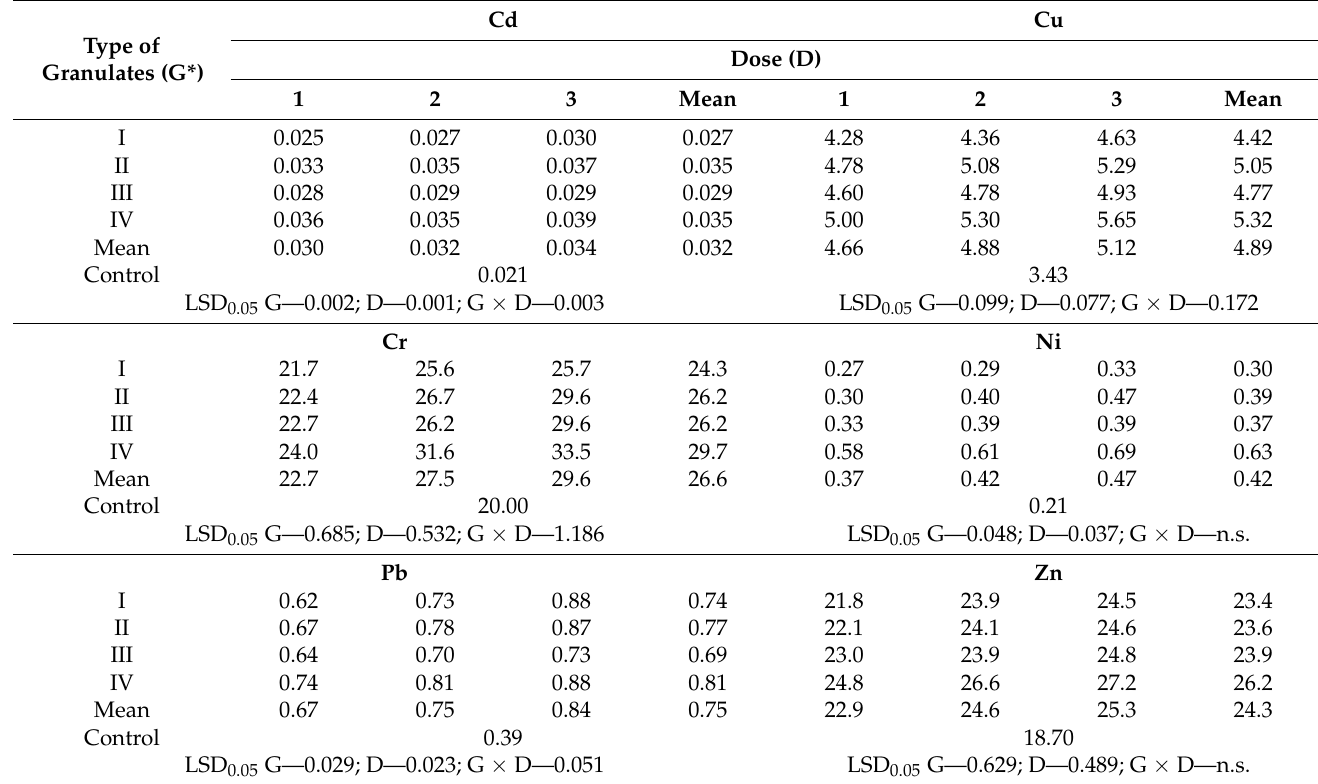
Table 5. Content of Cd, Cu, Cr, Ni, Pb and Zn in rape seeds (in mg · kg − 1 DM) to pot under the effect of sludge-ash